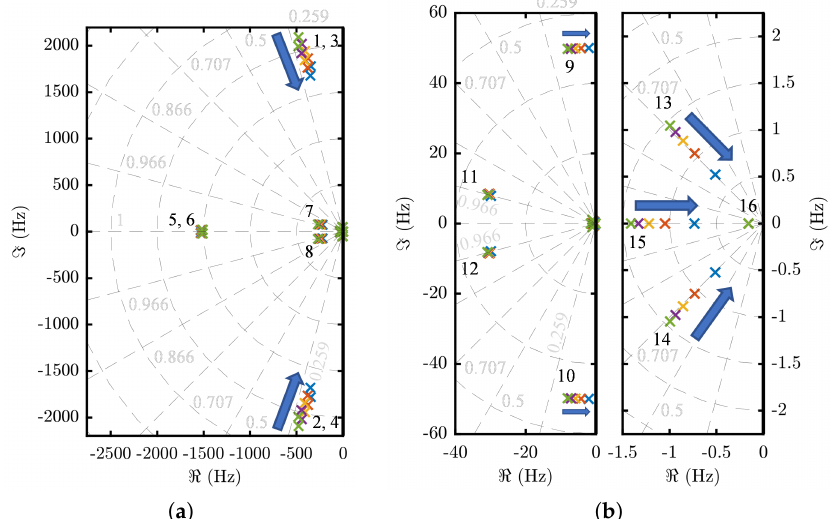
Figure 9. Pole map of the S-SVC when the SCR changes from 10 to 1.5. The arrows indicate a decrease in the SCR. The poles are numbered according to Table 1. From left to right: ( a ) Complete pole map; ( b ) Magnifications of the lower frequency